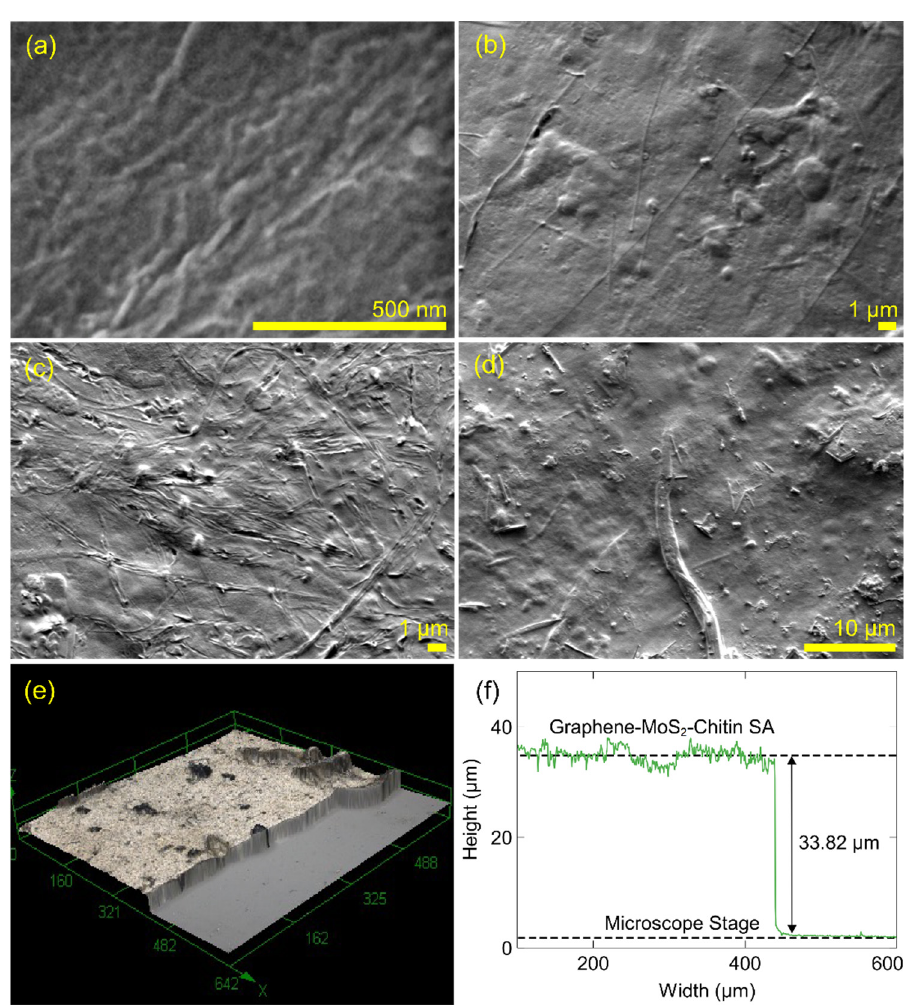
Figure 6. FESEM image of ( a ) chitin, ( b ) graphene-chitin, ( c ) MoS 2 -chitin, ( d ) graphene-MoS 2 -chitin, ( e ) 3D image profile and ( f ) thickness measurement from laser microscope.